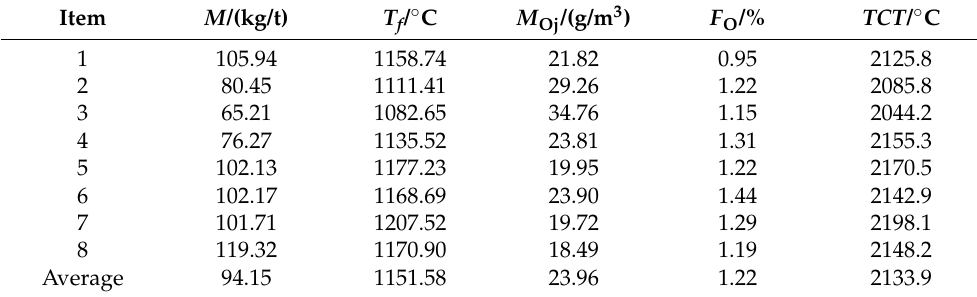
Table 2. Operation data of the 1280 m 3 BF in steelworks.